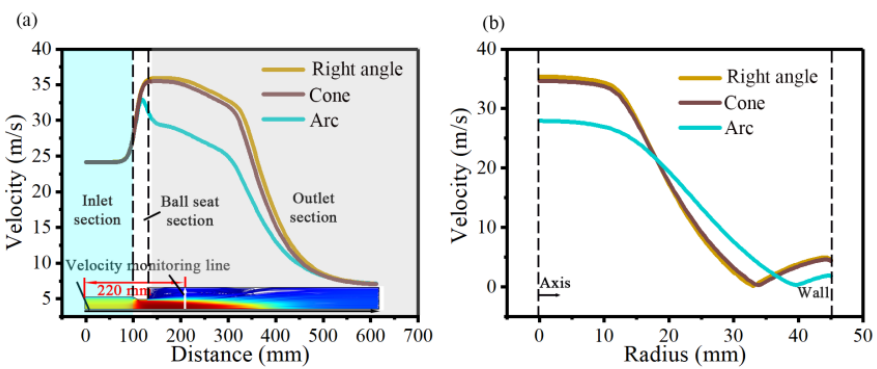
Figure 14. ( a ) Velocity distributions at the black velocity monitoring line with different diameters of the ball seat; ( b ) velocity distributions at the white velocity monitoring line with different diameters of the ball seat; the fluid viscosity was set as 100 mPa · s.